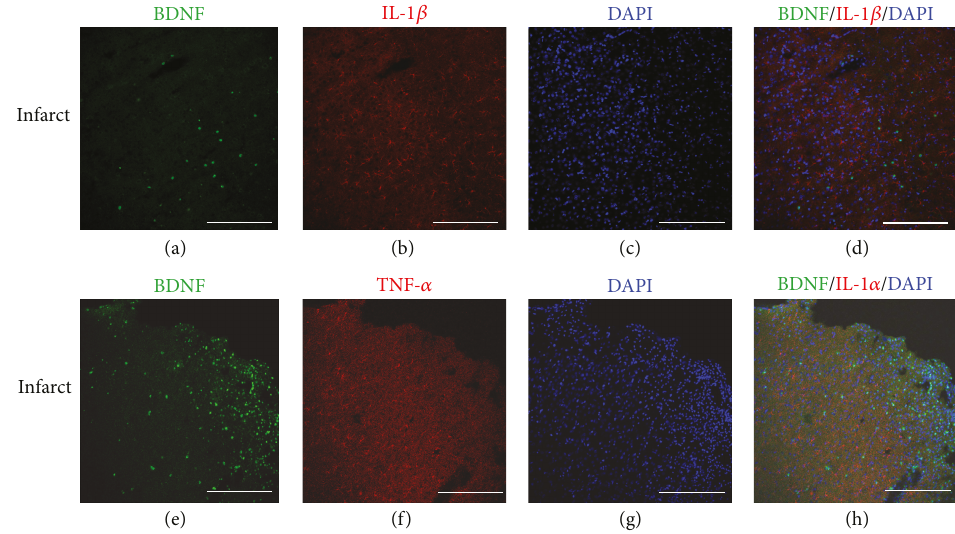
Figure 8: BDNF-producing cells do not overlap with TNF- α -or IL-1b-expressing cells at day 2. (a – d) Distribution of BDNF + cells and IL- β + cells in the infarct areas after MSC transplantation. (e – h) Distribution of BDNF + cells and TNF- α + cells in the infarct area after MSC transplantation. (a, e) BDNF staining. (b) IL- β . (f) TNF- α . (c, g) DAPI nucleus staining. (d) No double-stained BDNF + /IL- β + cells were found in the infarct area after dMCAO. (h) No BDNF + /TNF- α + cells were found 2 days after MSC transplantation in the striatum and corpus callosum after MSC transplantation. Scale bar, 250 μ